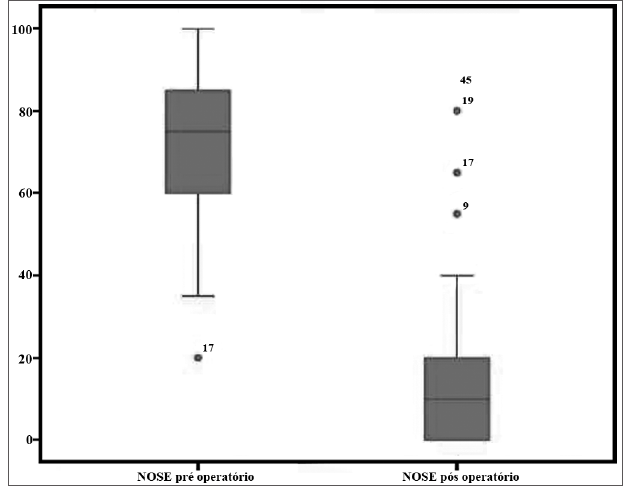
Figura 1. Pontuação pré-operatória e pós-operatória no questionário NOSE ( p < 0.001).